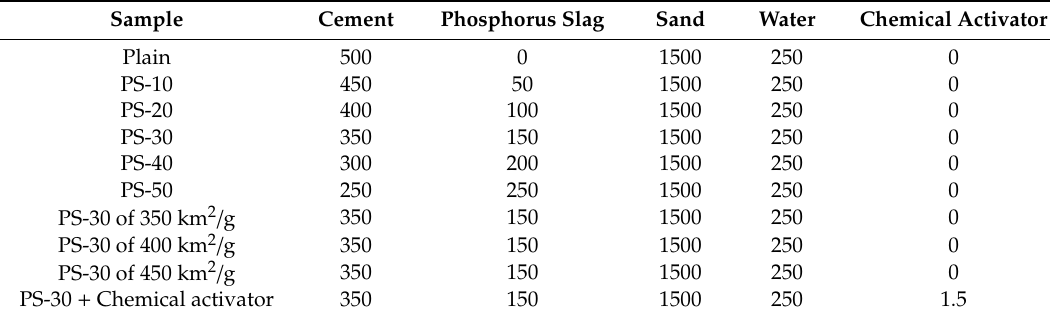
Figure 2. XRD pattern of phosphorus slag. Table 2. Mix proportion of mortar samples (kg / m 3 ).